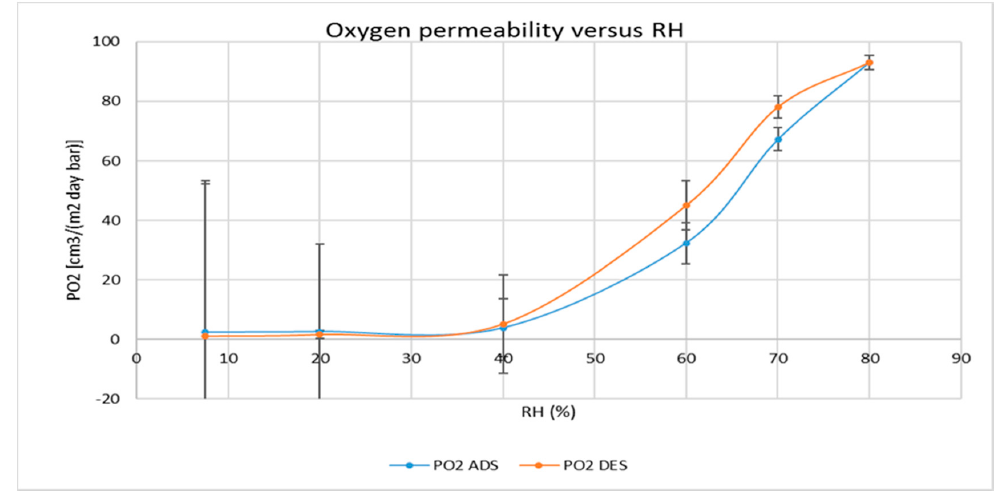
Figure 3. Oxygen permeability at 25 °C under different relative humidity (RH) values, both in adsorption and desorption, through the CNCs coated PET film.